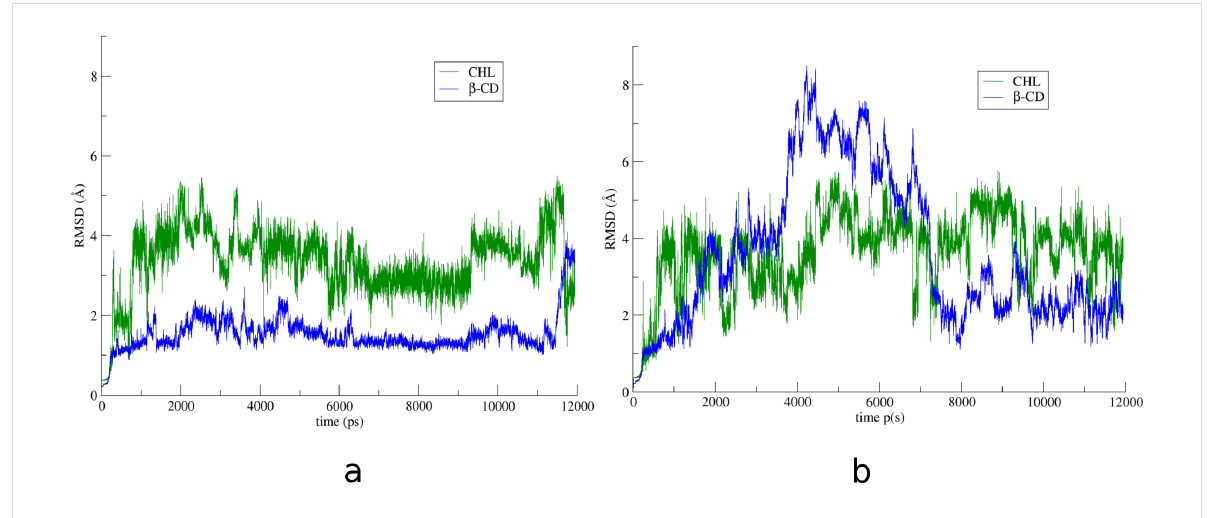
Figure 3: RMSD over time for all CHL (green) and β -CD (blue) atoms (a) at 300 K and (b) at 340 K.